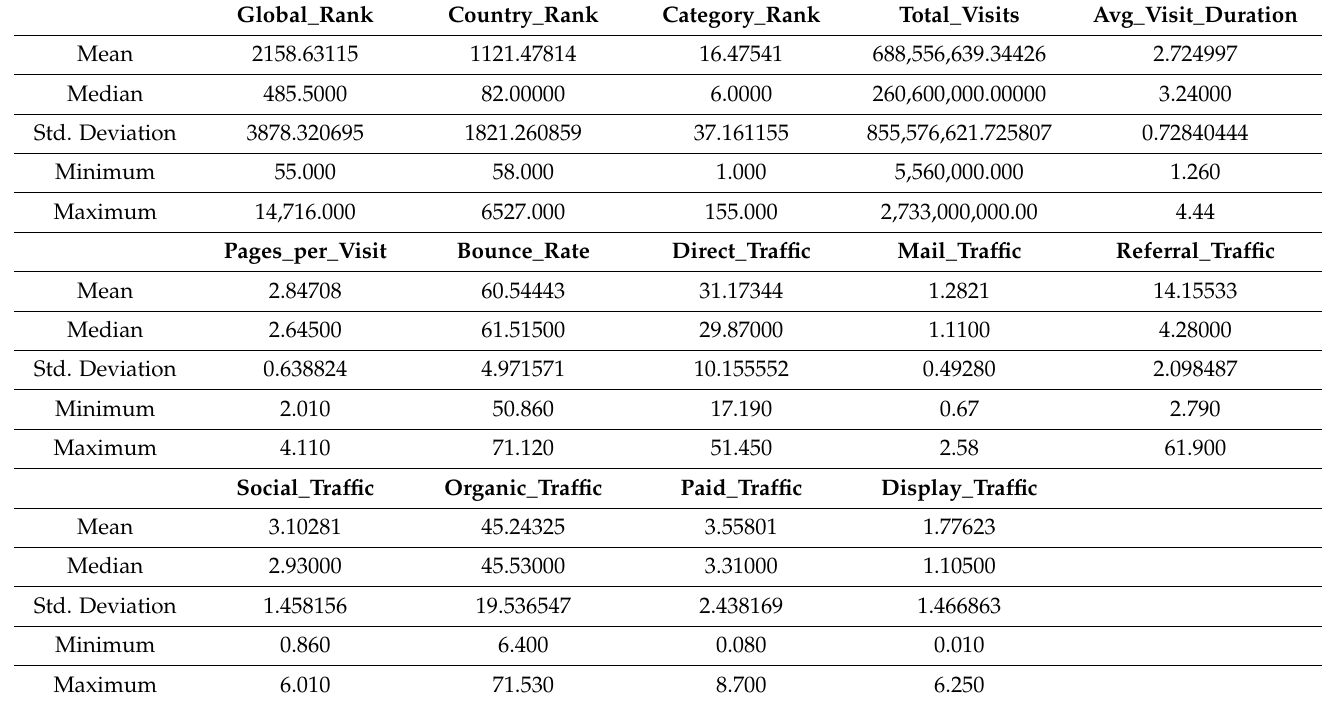
Table 4. Summary descriptive statistics for web analysis